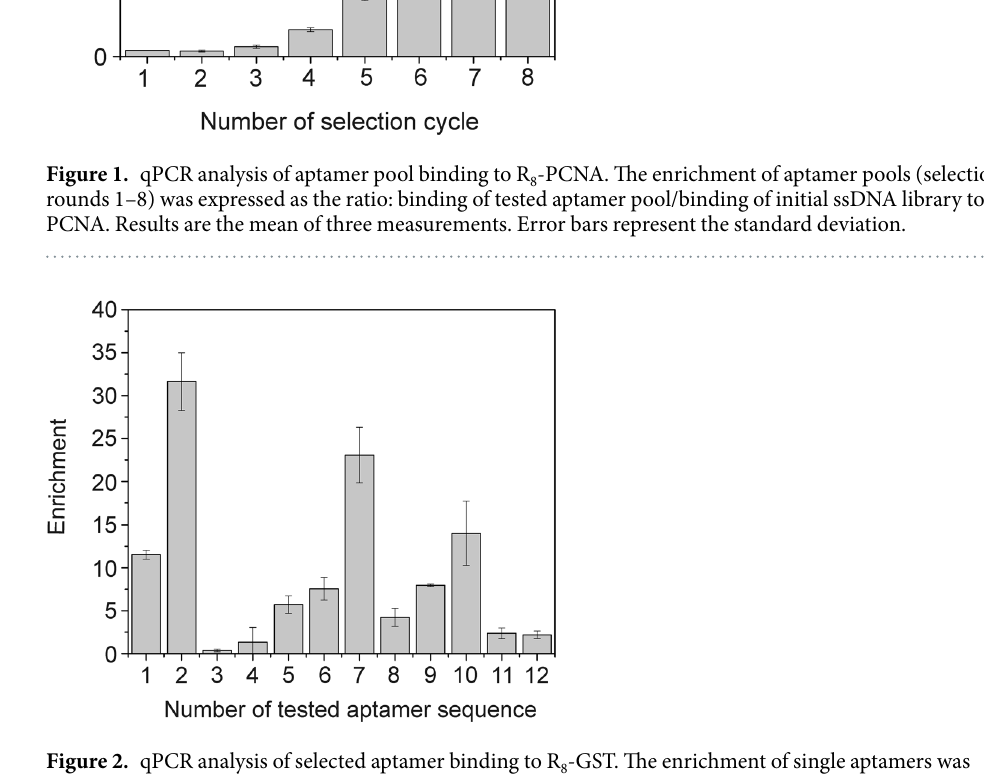
Figure 2. qPCR analysis of selected aptamer binding to R 8 -GST. The enrichment of single aptamers was expressed as the ratio: binding of tested aptamer/binding of reference aptamer to R 8 -GST. Results are the mean of three measurements. Error bars represent the standard